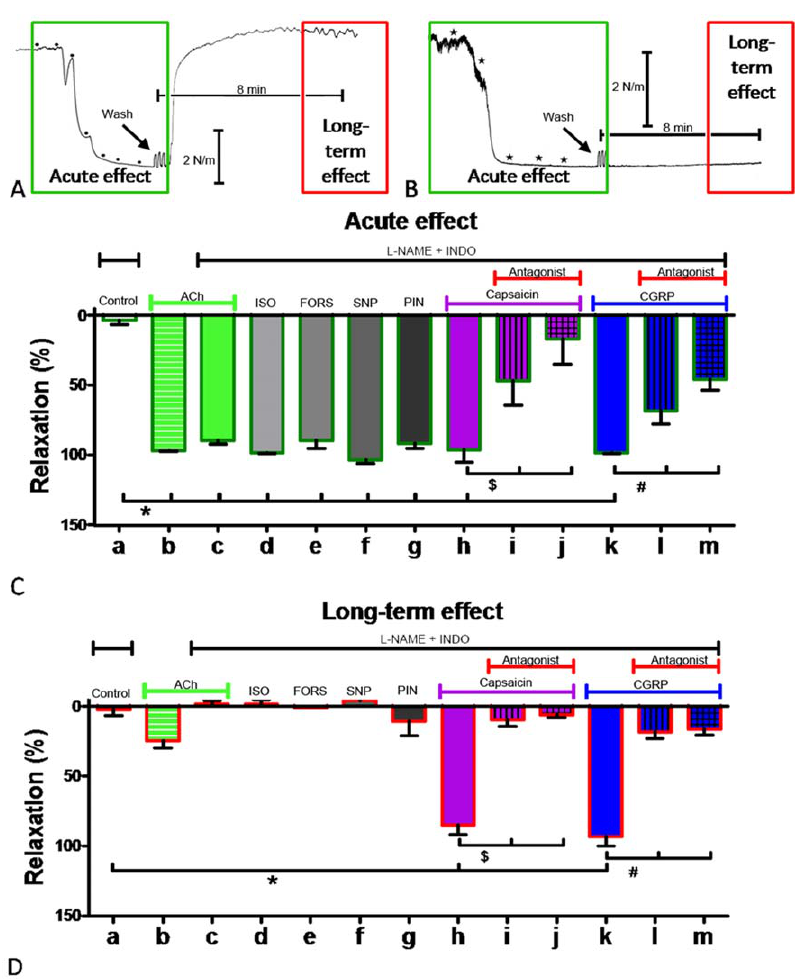
Figure 2. Capsaicin and CGRP relax endothelinergic arterial contraction and prevent the persistent contractile effect of ET-1. Isolated rat mesenteric resistance arteries were studied in presence of L-NAME (100 m M) and indomethacin (10 m M) (as indicated) and were contracted with ET-1 (16 nM). Increasing vasodilator concentrations were administered until a maximal effect was observed. Thereafter vasoconstrictor and vasodilator stimuli were removed from the organ chamber while the recording of active wall tension continued for . 10 min. A and B, typical tracings of active wall tension (WT) versus time (t) illustrating acute relaxing effects (green box) of acetylcholine (A; 0.01–10 m M) and capsaicin (B; 0.01–1 m M) and rapid recovery of contraction after removal of the vasodilator (long-term effect, red box) in the case of acetylcholine (A) but not capsaicin (B). C, maximal acute relaxing effects of various dilators. D, long-term effects of various dilators. a, time control; b and c, acetylcholine; d, isoproterenol; e, forskolin; f, Na-nitroprusside; g, pinacidil; h – j, capsaicin in the absence (h) and presence of CGRP 8-37 (i) or BIBN4096BS (j); k - m, CGRP in the absence (k) and presence of CGRP 8-37 (l) or BIBN4096BS (m). For concentrations of vasodilators see ‘‘Methods’’ section. n=6–8. *, $ and # : P , 0.05 vs. control, capsaicin or CGRP,